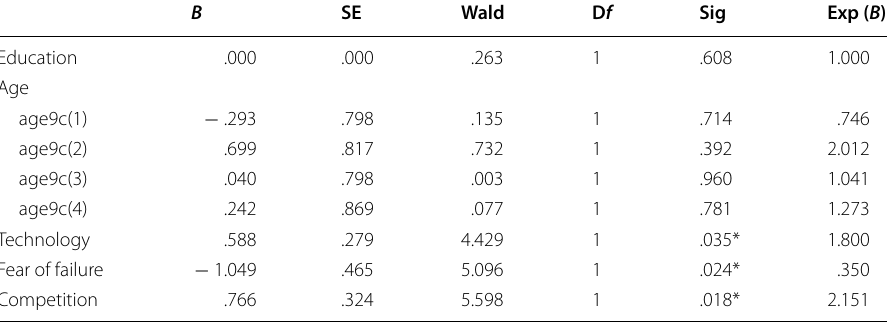
Table 5 Logistic